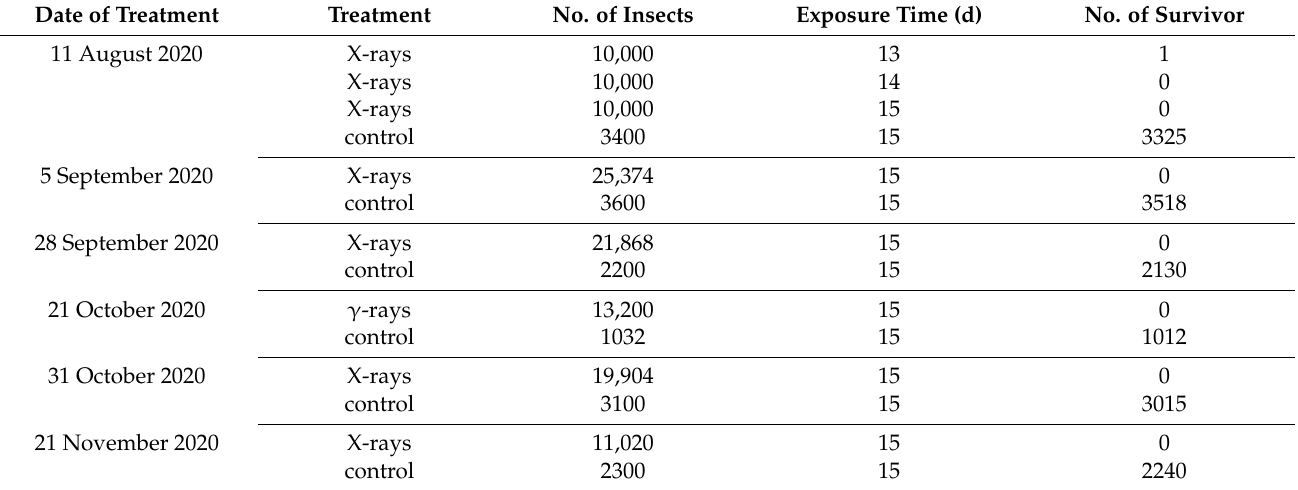
Table 5. Results of the confirmatory tests on T. granarium late-stage larvae treated at 24–26 °C under 1% O 2 atmosphere for 13~15 days after 200 Gy